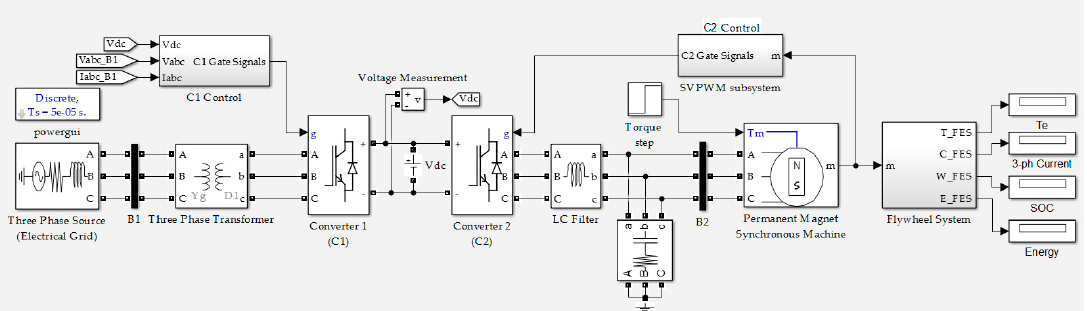
Figure 6. MATLAB-Simulink model of FESS.